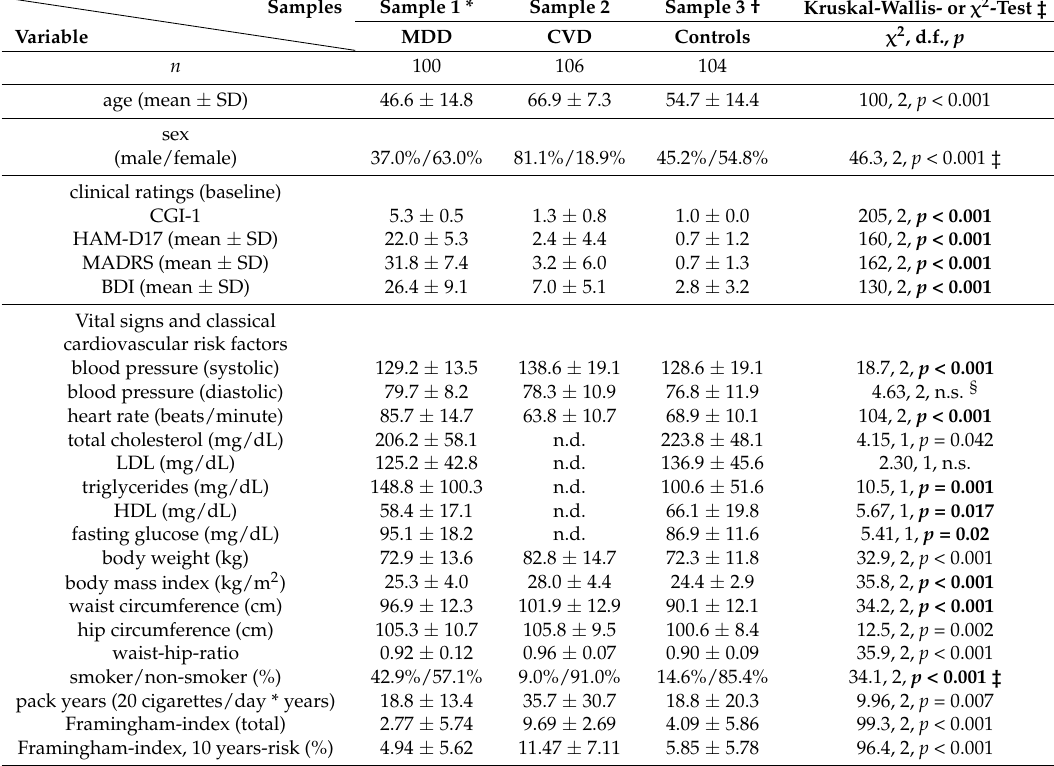
Table 1. Demographic, clinical, and medical characteristics of samples 1–3 including psychiatric ratings, vital signs, and selected classical cardiovascular risk factors. Vital signs as well as classical cardiovascular risk factors and behavioral variables are indicating an elevated cardiovascular risk in